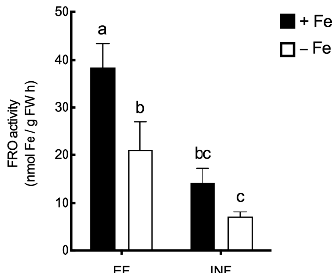
Figure 6. Root FRO activity (nmol Fe/g FW h) of efficient (EF) and inefficient (INF) soybean lines grown under Fe sufficiency (+Fe, 20 µM) or Fe deficiency ( − Fe, no Fe) for 14 days under hydroponic conditions. Data are means ± SE; different letters indicate significant differences ( p < 0.05) by ANOVA with Tukey correction test.